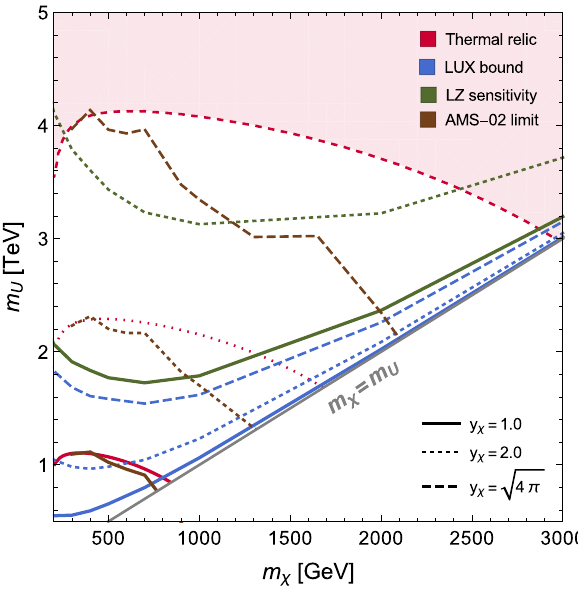
Fig. 2 The allowed region the m χ − m U plane for different choices of √ coupling λ χ = 1(solid),2(dotted)andperturbativelimit 4 π (dashed) are shown. The red curves satisfy the observed relic density [31]. The blue and green curves represent current limit from spin-dependent DM- neutron scattering cross section measurement by LUX [50] and future sensitivity of LZ experiment [51], respectively for the correspond- ing values of y χ . The region below these direct detection bounds are excluded at 90% confidence level. The brown curves depict the indirect detection bound from AMS-02 measurements [48,49] which excludes m χ ≤ 400GeV at 95% significance level. The rest of the parameter space is allowed by the current limits from both direct and indirect detection experiments however will completely be probed with future sensitivity of LZ